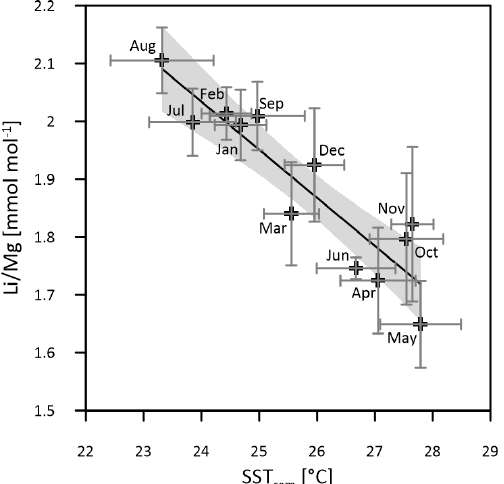
Figure 4. Multi-coral calibration of the Li / Mg thermometer with SSTs rem (monthly means 2003–2018, JPL MUR). Horizontal error bars (1 σ ) represent SST uncertainty between equal months of con- secutive years (2003–2018), and vertical error bars (1 σ ) represent uncertainty of multi-year monthly mean Li / Mg ratios between the three Masirah corals. The grey shaded area indicates the 95% con- fidence interval of the linear regression.